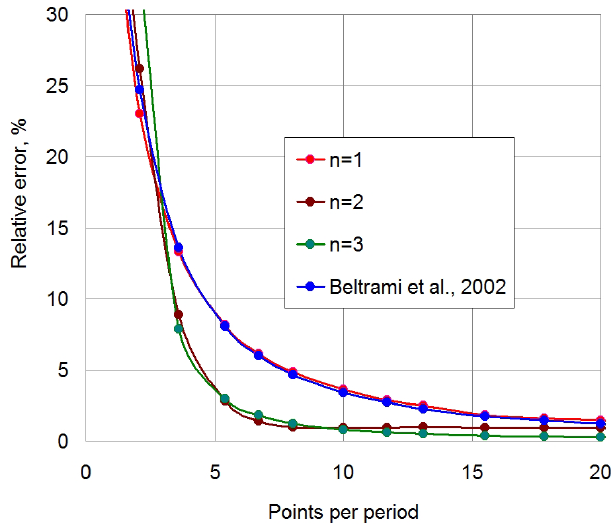
Figure 1. Testing the algorithms of GST–SHF transformation by applying it to a harmonic function of GST change. Relative error of SHF estimation (the ratio of the standard error of the SHF es- timation to the real amplitude of SHF variations) versus the GST discretization frequency (points per period).